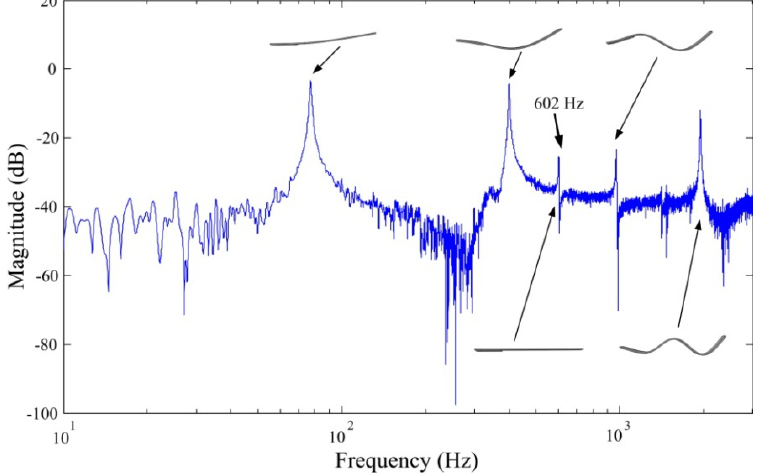
Figure 10. Frequency response of the smart cantilever beam obtained by the FBG strain